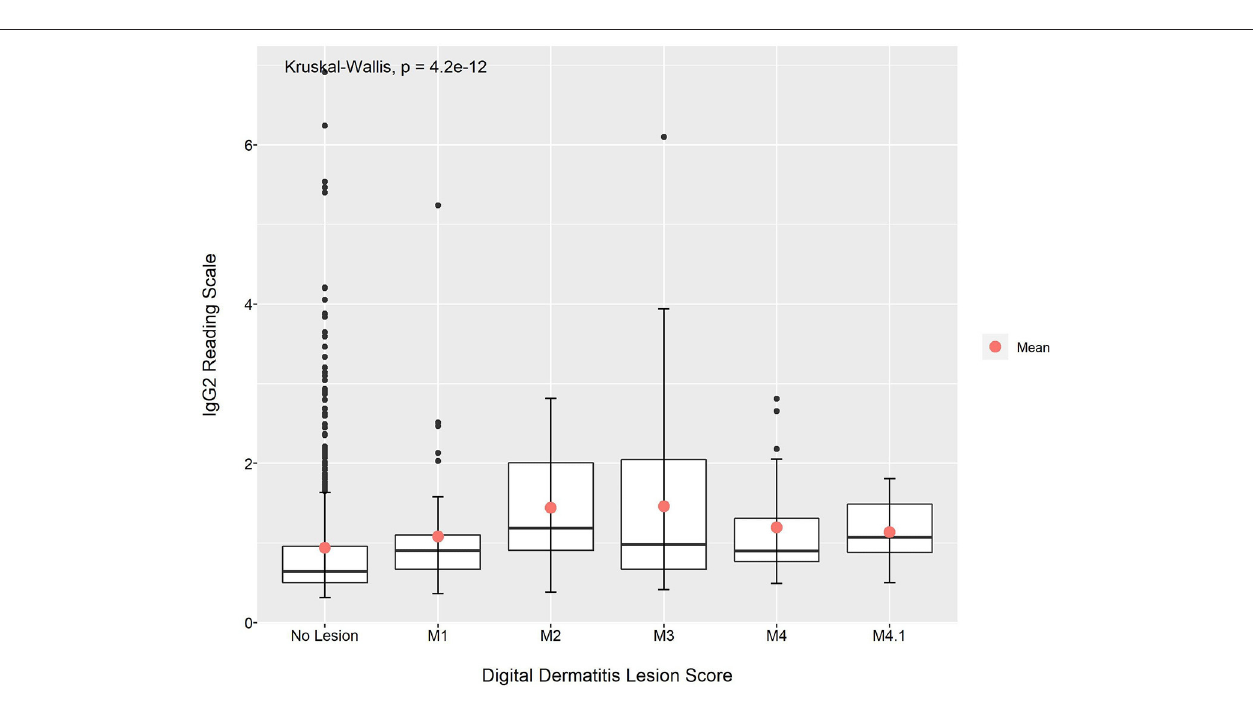
lactation had roughly half the odds of having a DD lesion when compared with cows in their first lactation (0.56 OR, 95% CI 0.36–0.86; Table 6